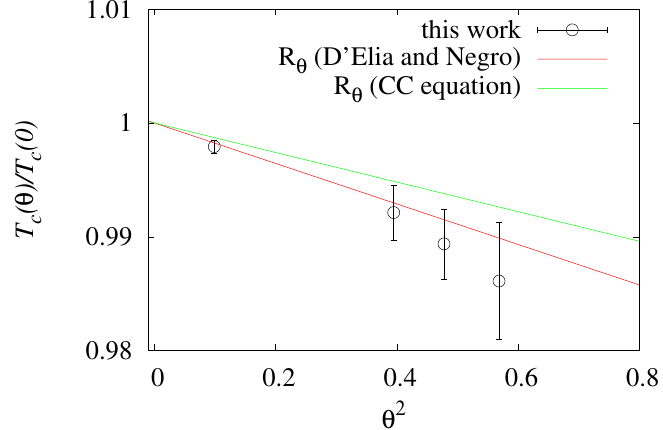
Figure 11 . Comparison of our result for T c ( θ ) /T c (0) with the result of [1, 2]. R θ obtained through the CC relation is also